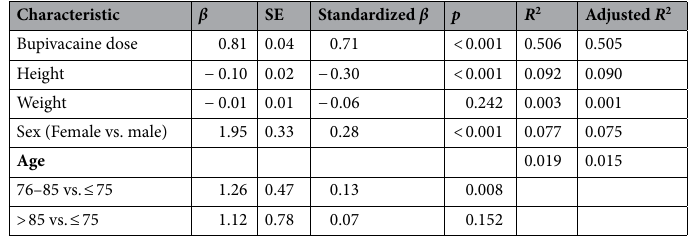
Table 2. Univariate effect of collected variables on peak block level. β , regression coefficient; SE, standard error; R 2 , coefficients of determination.